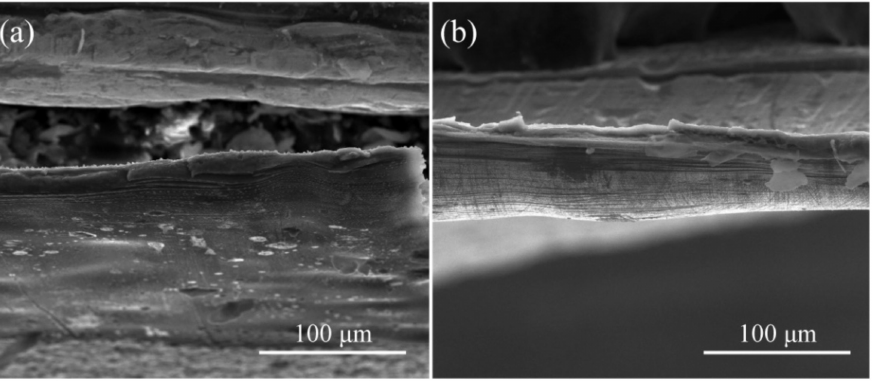
Figure 4. SEM images showing fracture of the magnesium-based amorphous alloy ribbons: ( a ) Mg 64 Zn 30 Ce 6 and ( b ) Mg 62 Zn 30 Ce 8 . SEM images showing the ribbon fracture morphology are presented in Figure